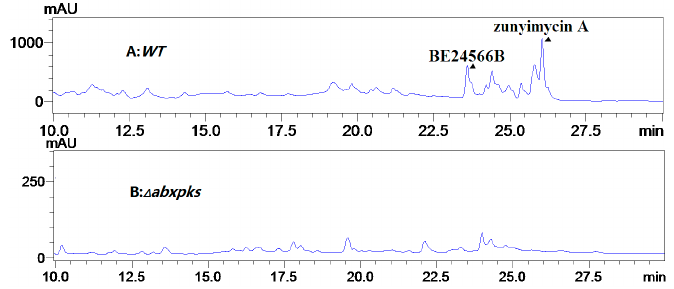
Figure 4. Metabolite profiling analysis of ABX biosynthesis. ( A ) Wild-type strain; ( B ) abxpks-deleted mutant strain.